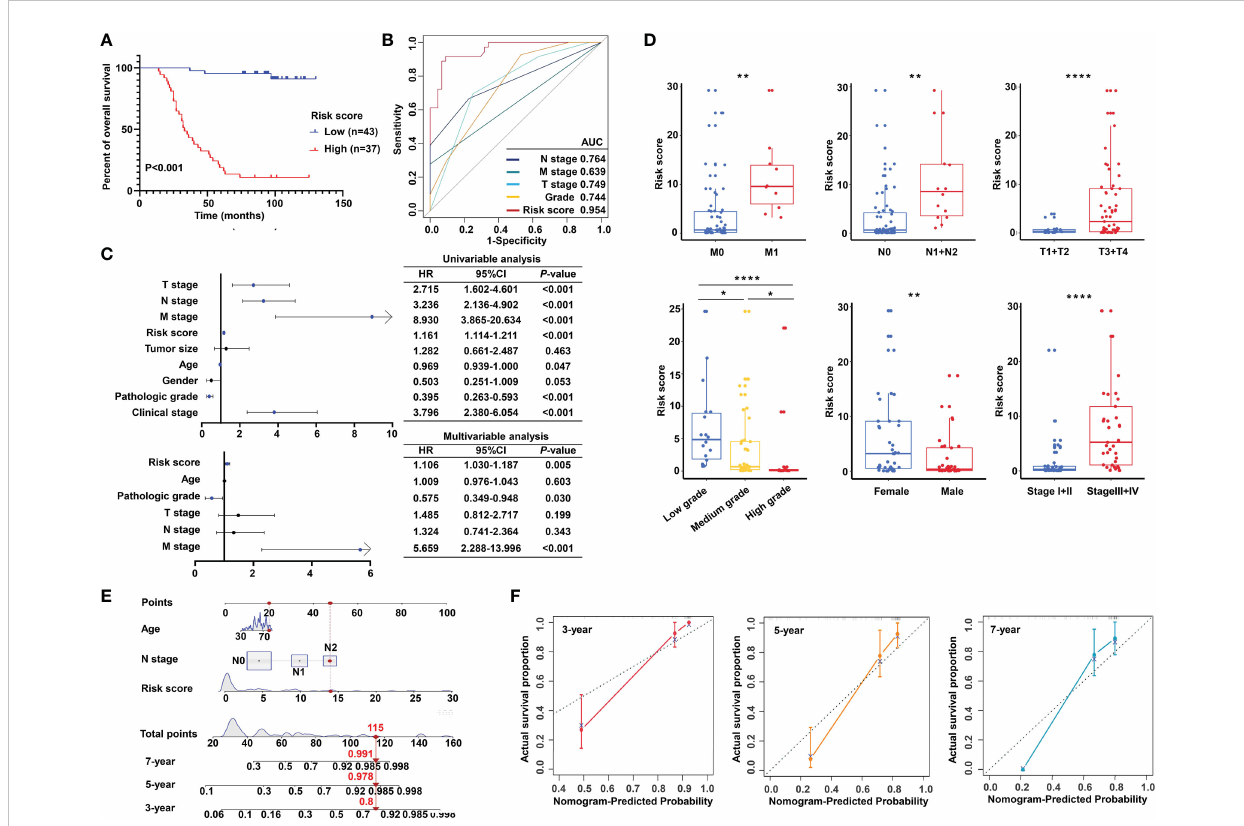
FIGURE 11 Validation of the m 5 C methylation – based signature by tissue microarray (TMA). (A) Kaplan – Meier survival curves show overall survival for low- and high-risk patients based on the rectal cancer TMA cohort. (B) The ROC curves depicted for the risk score and common clinical diagnostic indexes. (C) The univariate and multivariate Cox analysis of the risk score and clinicopathological indexes in the rectal cancer TMA patients. (D) The distribution of the risk score among various parameters including pathological TNM, stage, grade, and gender. (E) A nomogram integrated age, pathological N, and risk score was constructed for 3, 5, and 7 years based on the rectal cancer TMA cohort. (F) The calibration curves show the discrepancy between actual and nomogram-predicted survival probability in 3-, 5-, and 7-year nomograms. ****P < 0.0001; **P < 0.01; *P <